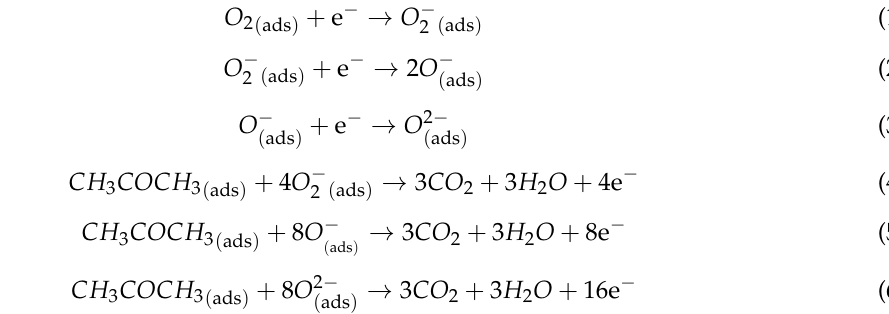
Figure 10. Stability measurement of the sensor based on MgFe 2 O 4 /g-C 3 N 4 -10-10 to 500 ppm acetone at 320 °C.